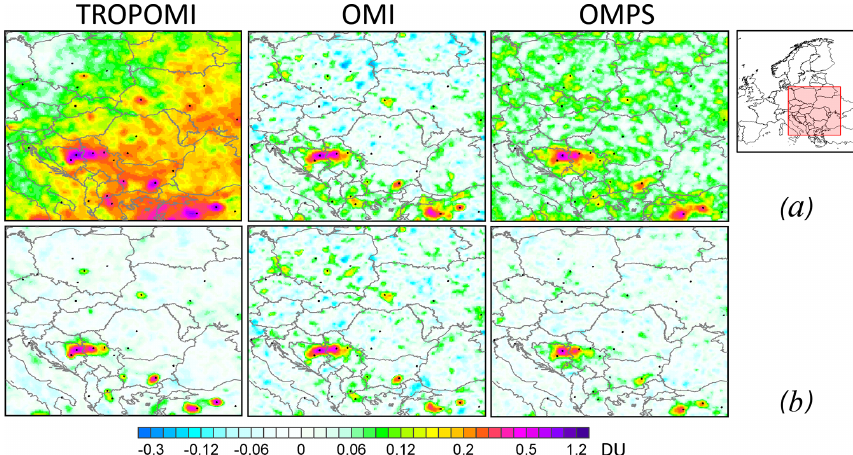
Figure 5. TROPOMI, OMI, and OMPS mean SO 2 over eastern and southern Europe for the period from April 2018 to March 2019 (a) and the same data but with large-scale biases removed (b) . Data are smoothed by oversampling/pixel averaging with R = 30km. The black dots indicate the SO 2 emissions